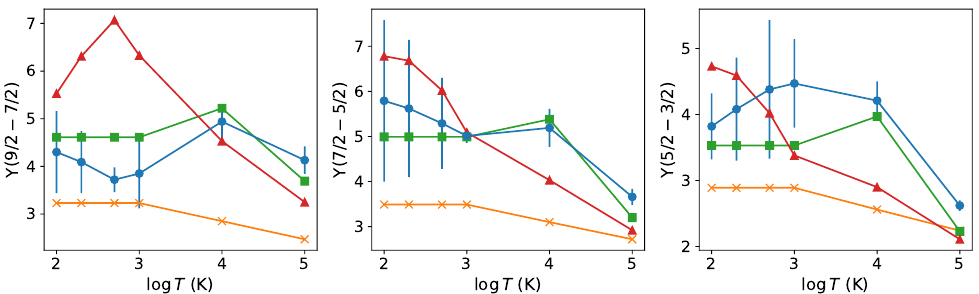
− a 6 D J (cid:48) within the ground term of [Fe II ]. J